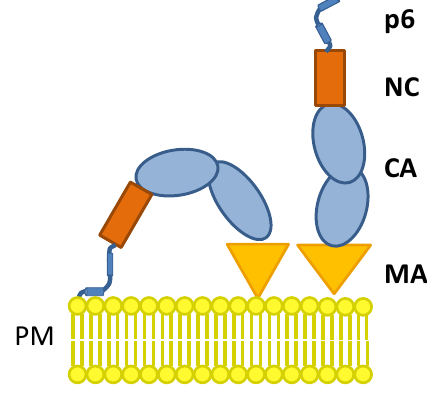
Figure 10. Model of the membrane interaction of Gag mediated by MA and the C-terminal α-helix of